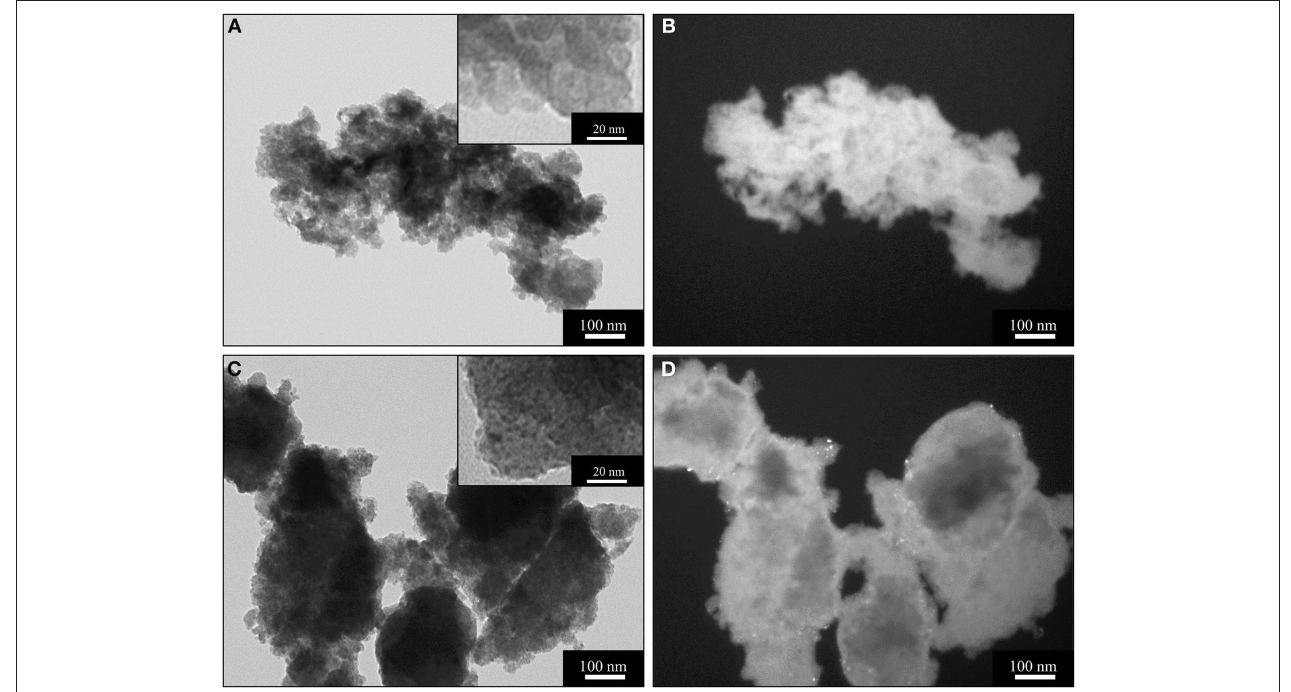
FIGURE 3 | BF (left) and DF (right) TEM images of the sample X_15_CeO 2 thermally treated at 450 ◦ C (A,B) and 900 ◦ C (C,D)